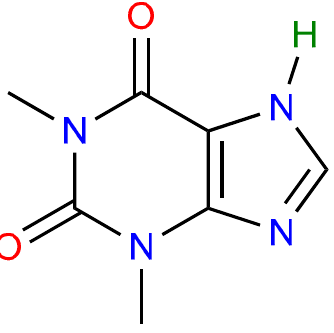
Figure 1. Structural formula of theophylline.